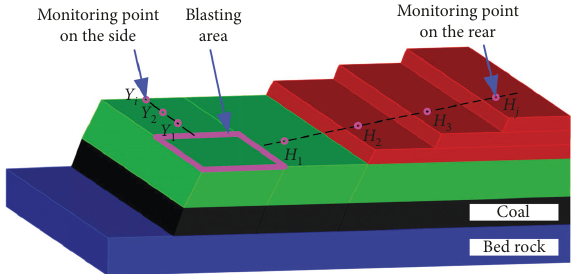
Figure 8: Sketch map of layout of monitoring points.